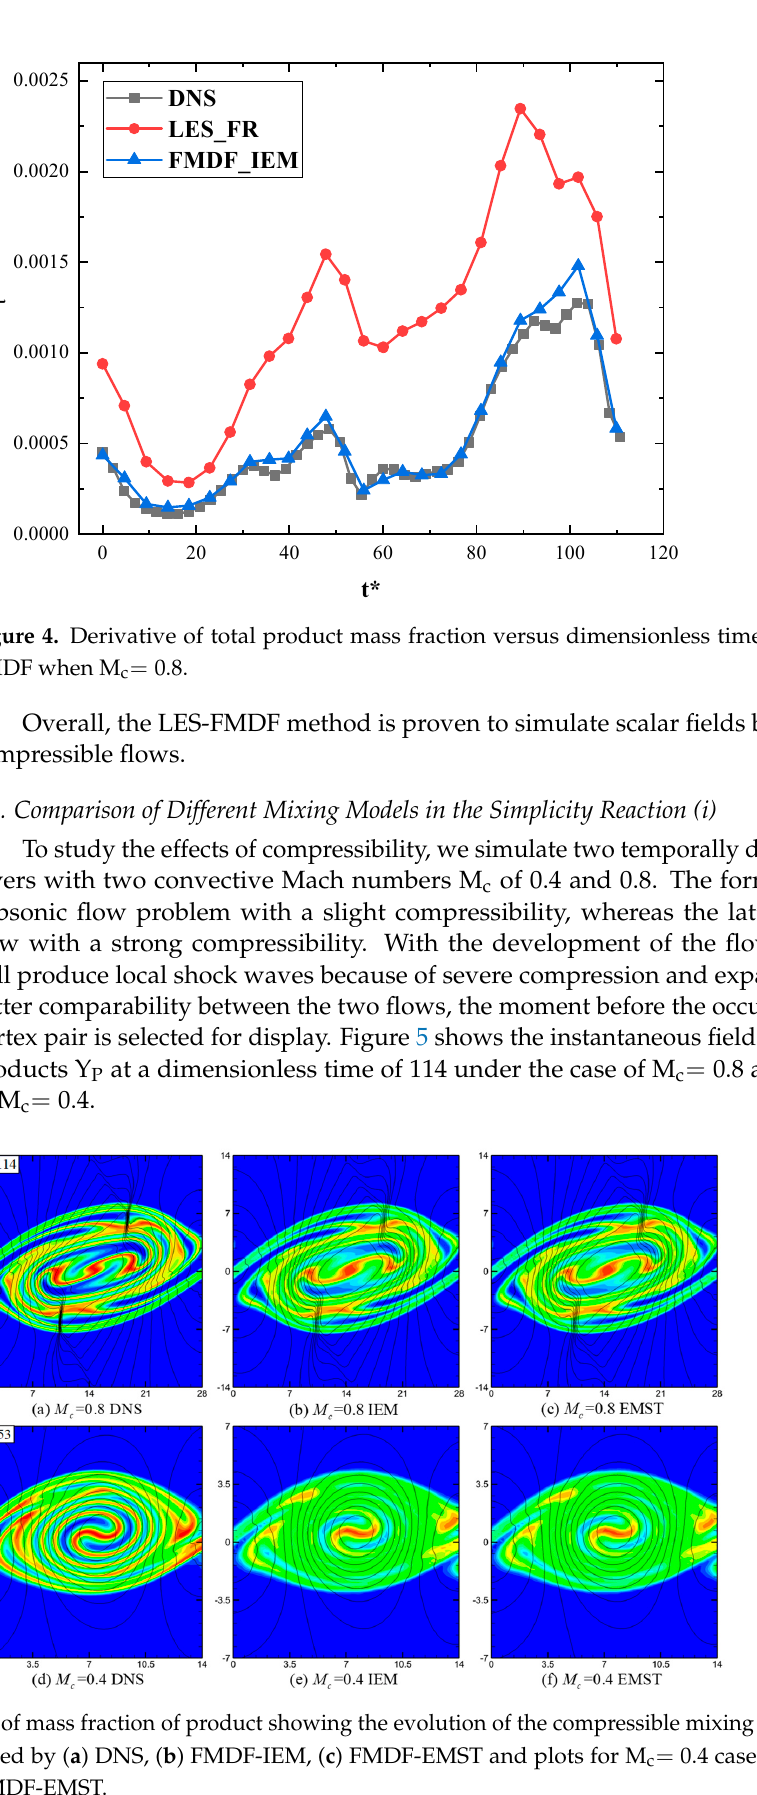
Figure 3. Mean of the total product mass fraction versus dimensionless time of DNS, LES, and FMDF when M c = 0.8.